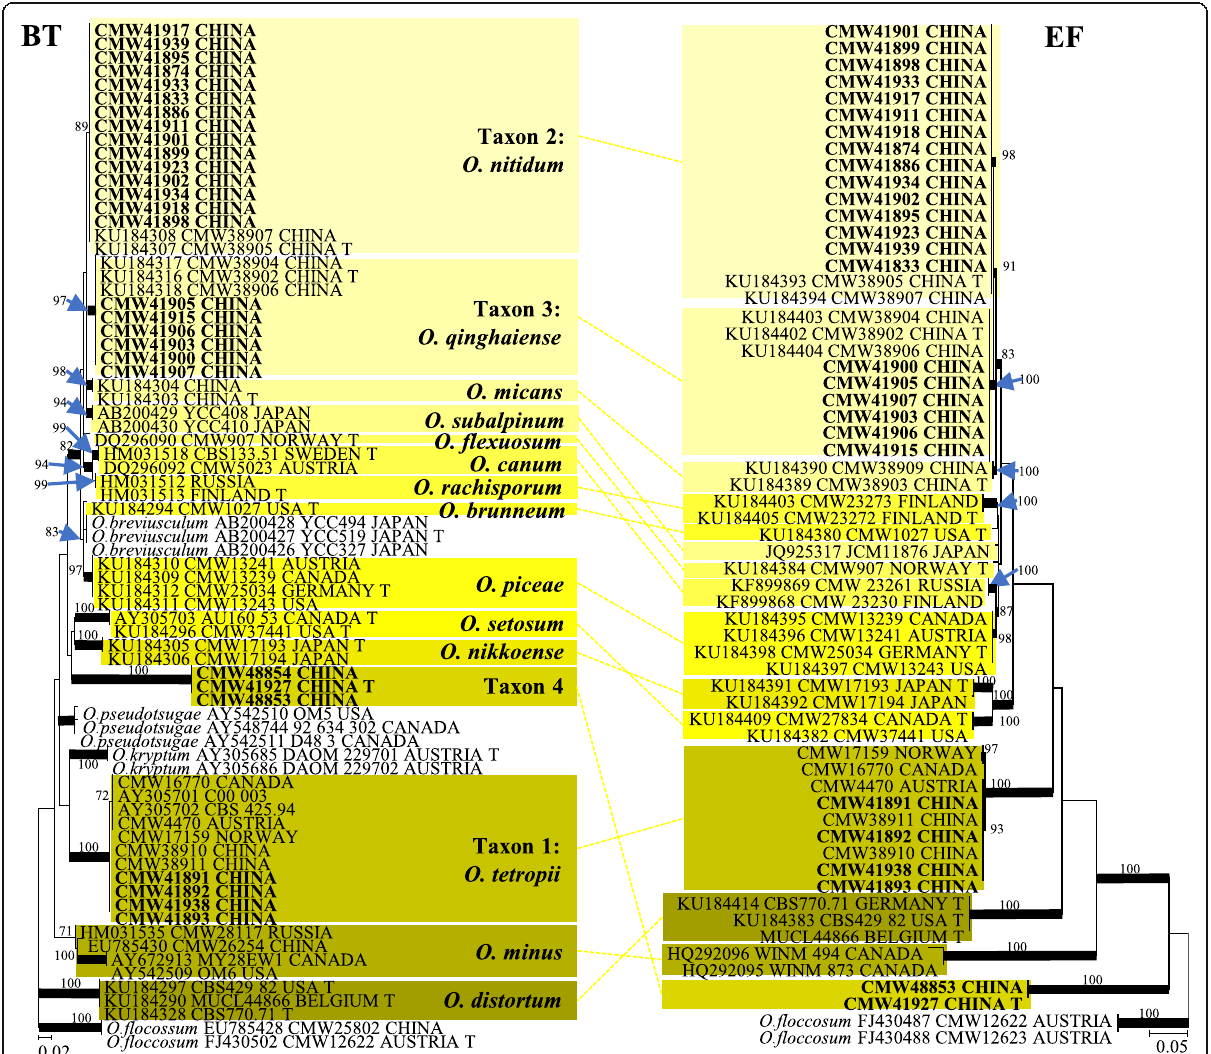
Fig. 3 Phylogram obtained from ML analyses of the partial BT and EF gene of O. piceae complex. Sequences obtained in this study are printed in bold type. ML bootstrap support values (1000 replicates, normal type) above 75% are indicated at the nodes. Posterior probabilities (above 0.9) obtained from BI are indicated by bold lines at the relevant branching points. T = ex-type cultures. Scale bar = total nucleotide difference between